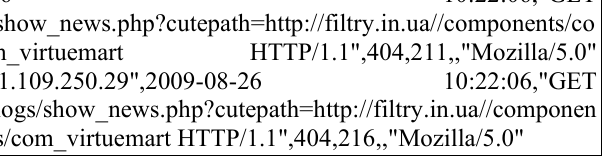
Figure 3. Examples of web user’s request